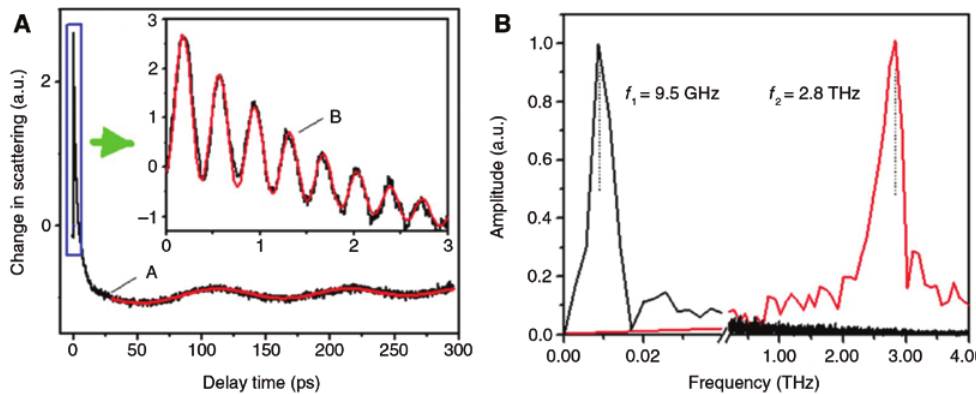
Figure 11: Coherent phonons in Bismuth nanowires. (A) Transient reflectivity signals obtained on Bi nanowires. Inset: Zoom in on the first picoseconds of the signal. (B) Spectral analysis of the oscillating portions of the signal. Reproduced from [78], with the permission of AIP